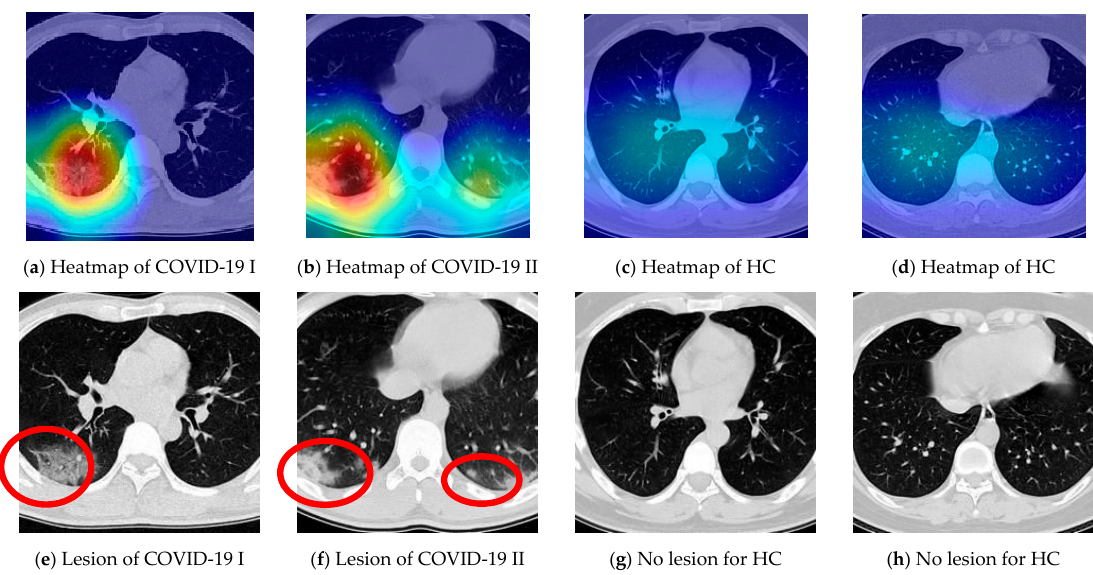
Figure 17. Delineation of COVID-19 samples. The lesion area in ( e , f ) is circled in red.